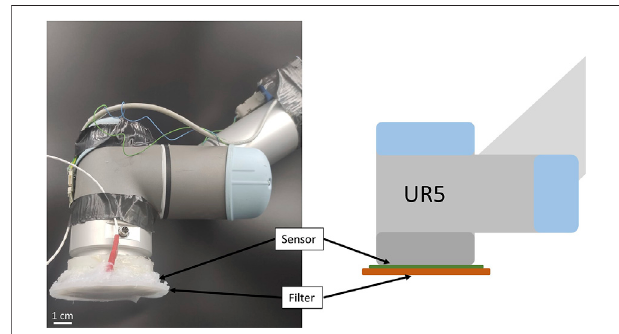
FIGURE 1 | On the left, implementation of the active touching system composed of UR5 robotic arm, tactile sensor, and tactile fi lter. On the right, schematics of the